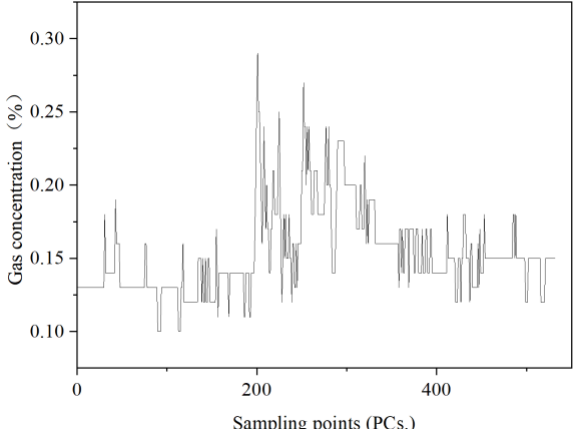
Figure 7. Gas data original signal.